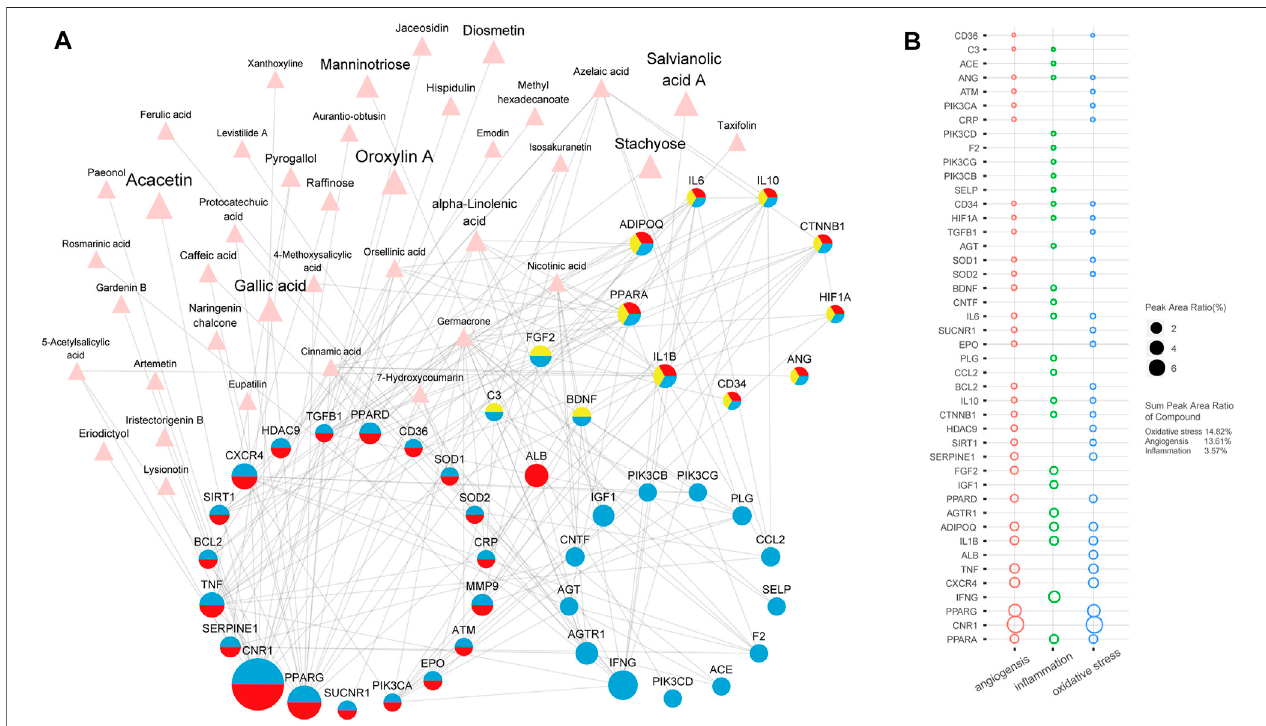
FIGURE 5 | Analysis of the content ratio and action intensity in different pathological processes of HXMM. (A) Hierarchy network of chemical compound, drug- attacked nodes in the AMD network, and DR-related pathological processes. This network was composed of the interaction relationship between HXMM ’ s intervention in AMD and DR disease-related potential compounds and the targets of oxidative stress, in fl ammation, and angiogenesis. The pink triangle represents the potential compound of HXMM, the red circle represented the special target of oxidative stress, and the blue circle represented the special target of in fl ammation. A circle composed of multiple colors indicates that the target exists in multiple processes at the same time. There were 9 targets (composed of red, blue, and yellow) shared by oxidative stress, in fl ammation, and angiogenesis, 19 targets (composed of red and blue) can be seen in oxidative stress and in fl ammation, and 3 targets (composed of red and yellow) shared by oxidative stress and angiogenesis. (B) The bubble plot of the sum of peak area ratios of target-related compounds involved in the angiogenesis, in fl ammation, and oxidative stress. The abscissa denotes the three pathological processes mentioned in panel 5A, and the ordinate is the target in panel 5A. The size of the bubbles is related to the ratio of the total peak area of the target-related compounds.